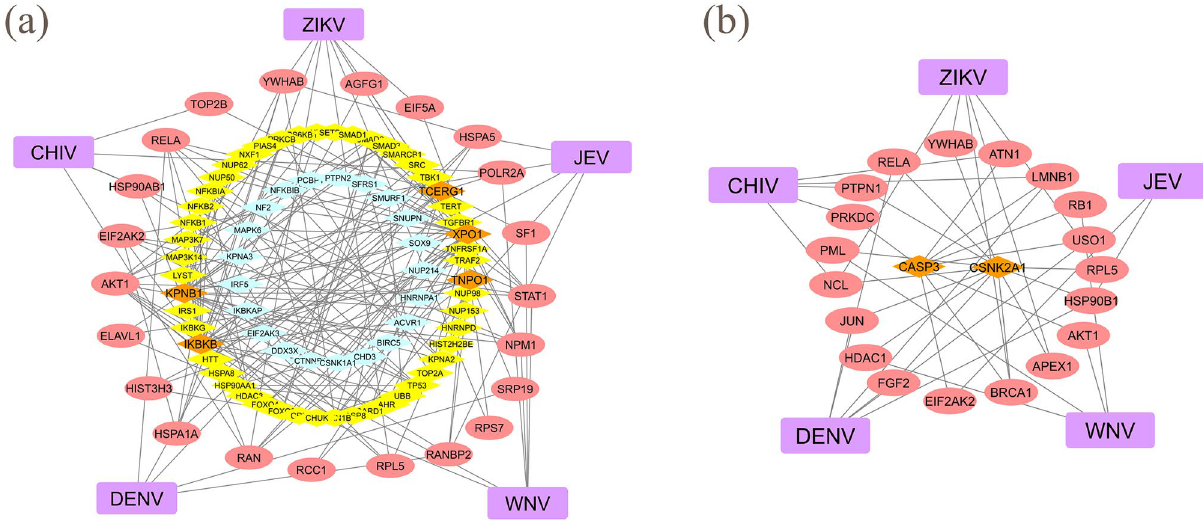
Figure 8. ( a ) Minimum network with a low degree of the target proteins. The target proteins, which are shared proteins TNPO1, TCERG1, IKBKB, KPNB1 and XPO1 with 50 or less degrees, are shown as orange diamonds. Common (red ellipses) and extended (yellow diamonds) signature proteins in this network are connected to the five viral infections (purple round squares). Twenty-one added proteins are shown as light blue diamonds. ( b ) Minimum network with a high degree of the target proteins. The target proteins, which are shared proteins CASP3 and SNK2A1 with greater than 130 degrees, are shown as orange